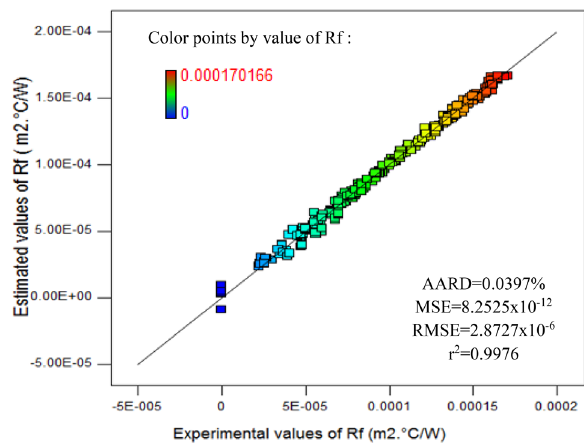
Figure 2. RSM estimation versus experimental